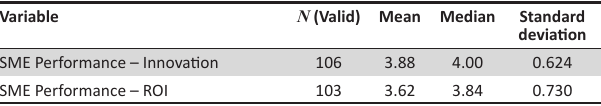
TABLE 3: Firm performance.